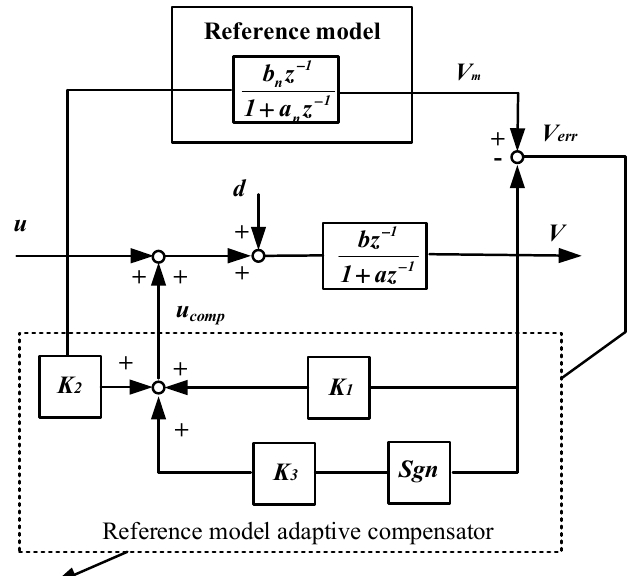
Figure 6. The model reference adaptive control method for the single axis system.